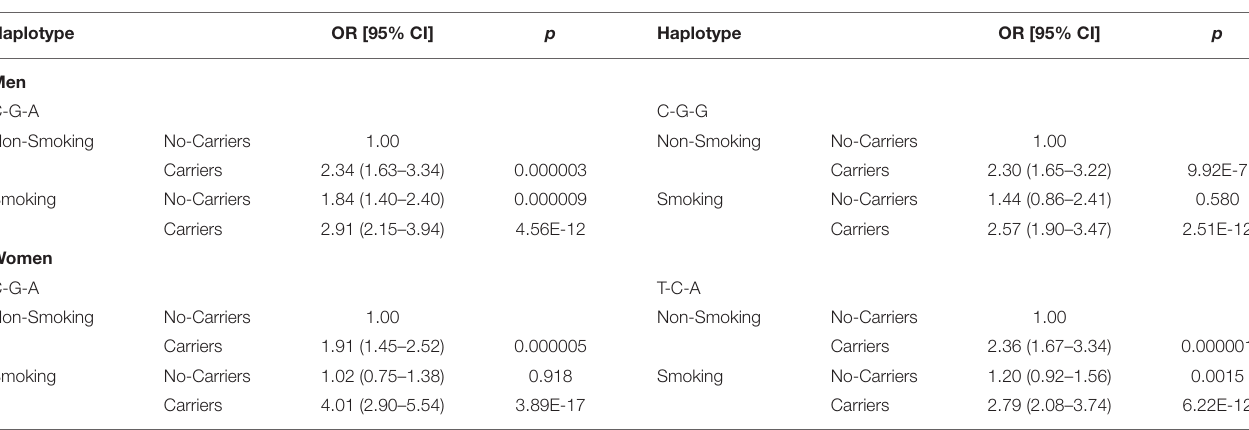
TABLE 10 | Interactions of the haplotypes and smoking on the risk of EOCAD.